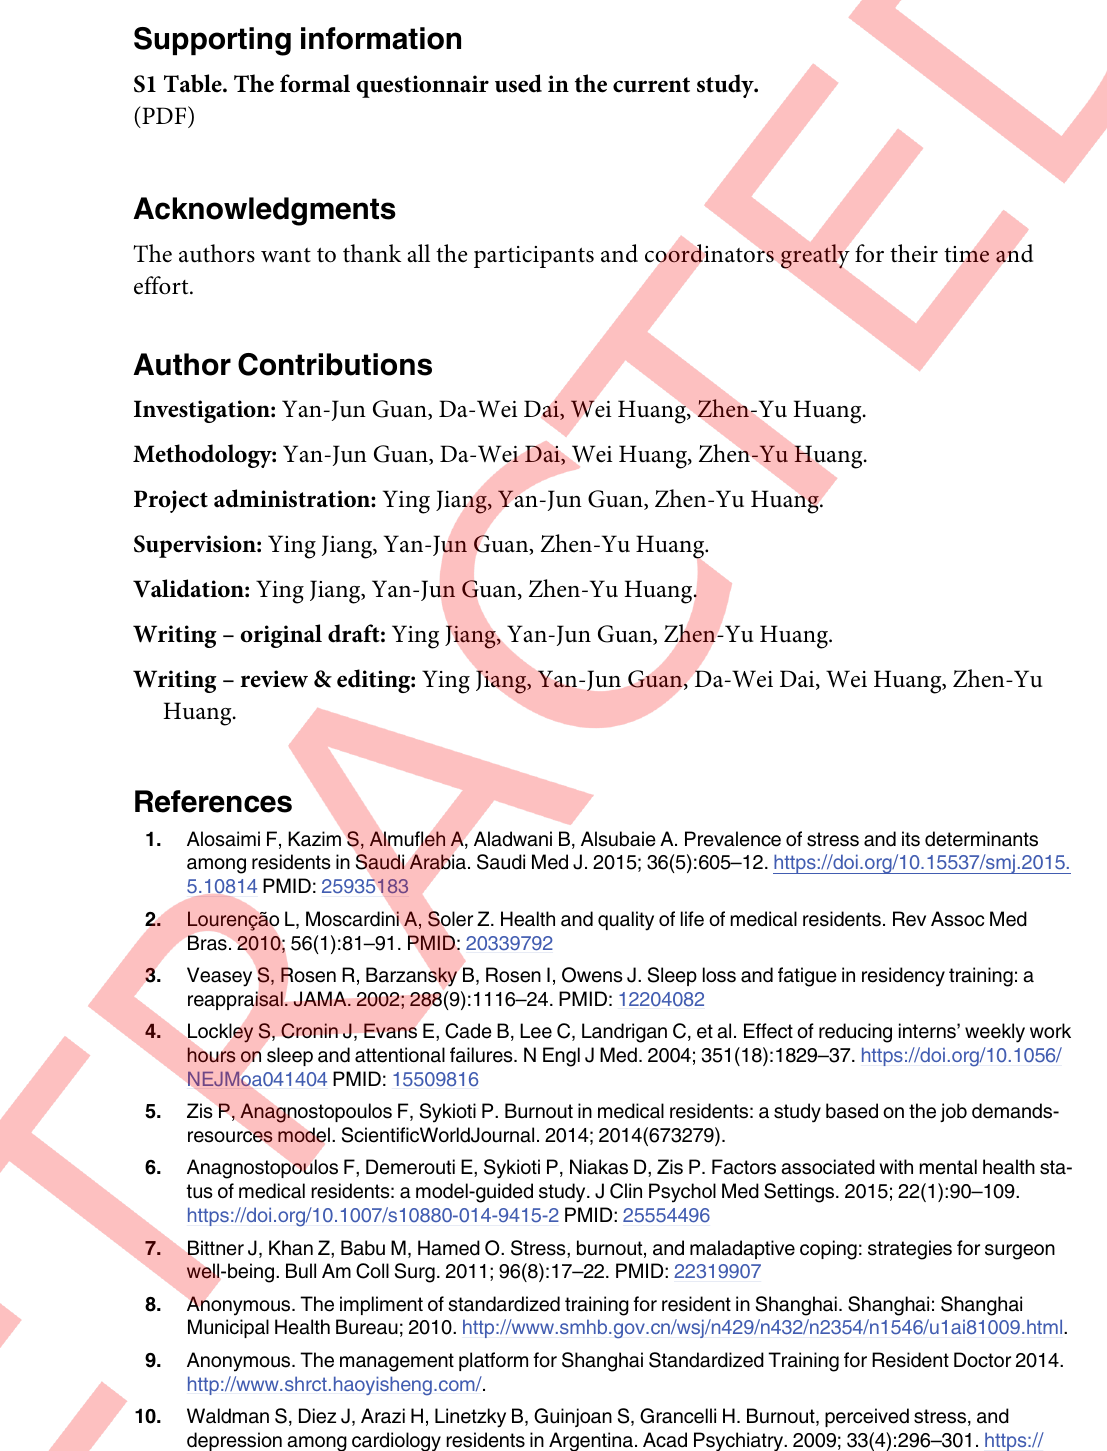
S1 Table. The formal questionnair used in the current